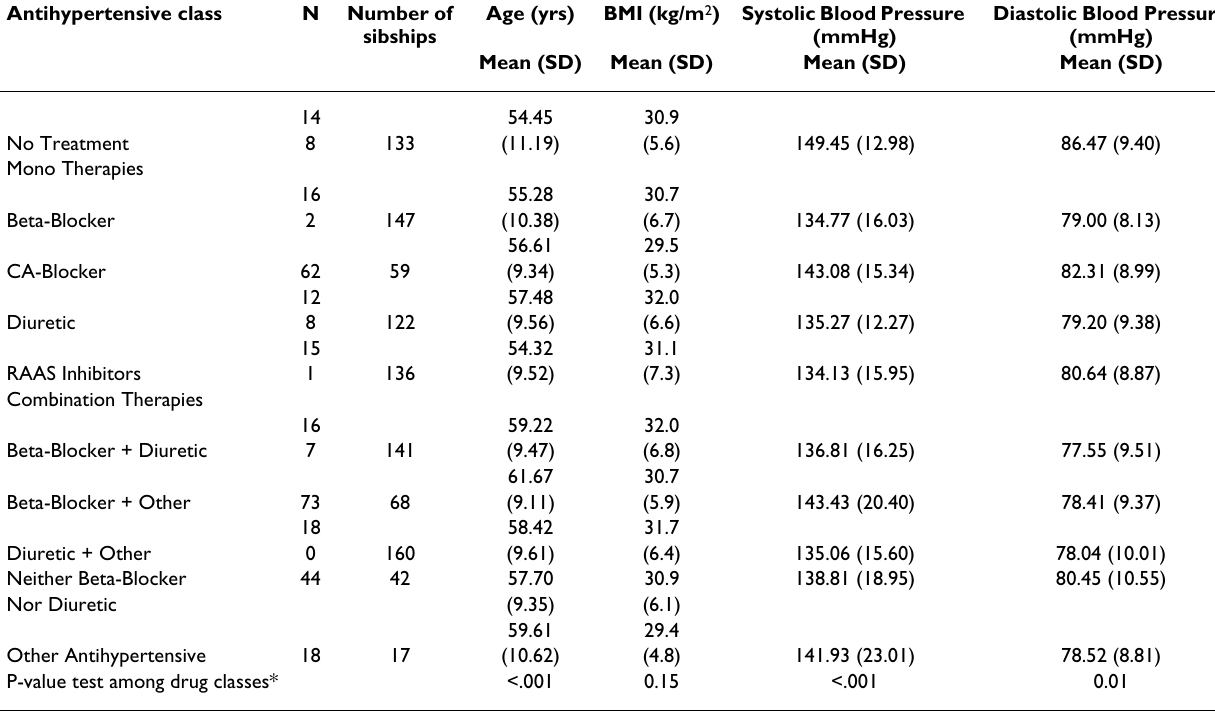
Table 1: Distribution of antihypertensive therapies Antihypertensive class